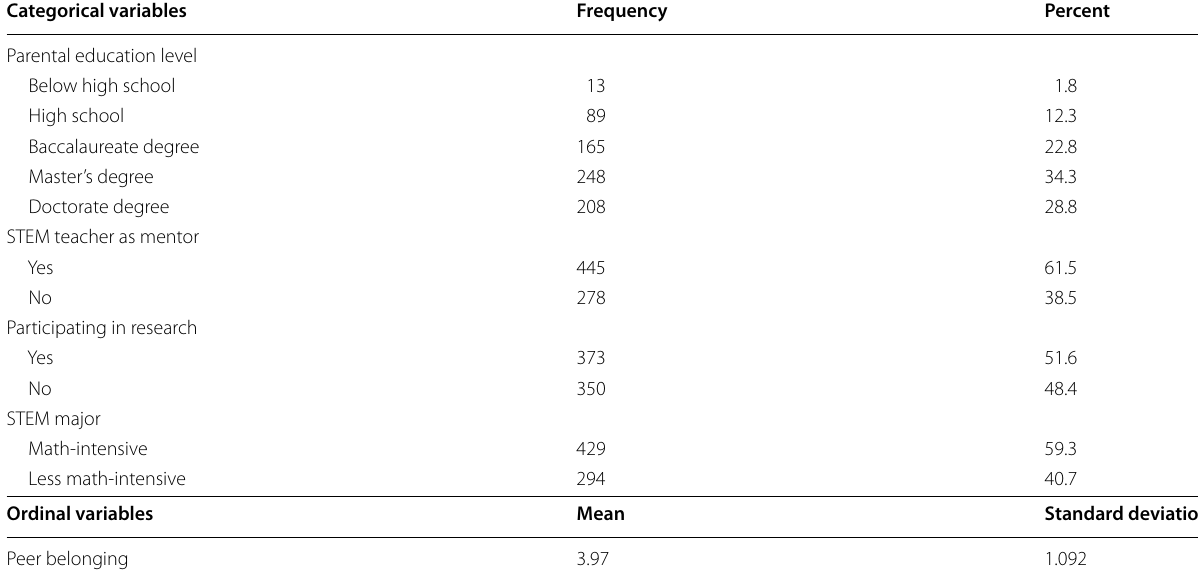
Table 3 Descriptive statistics for measured variables in analysis